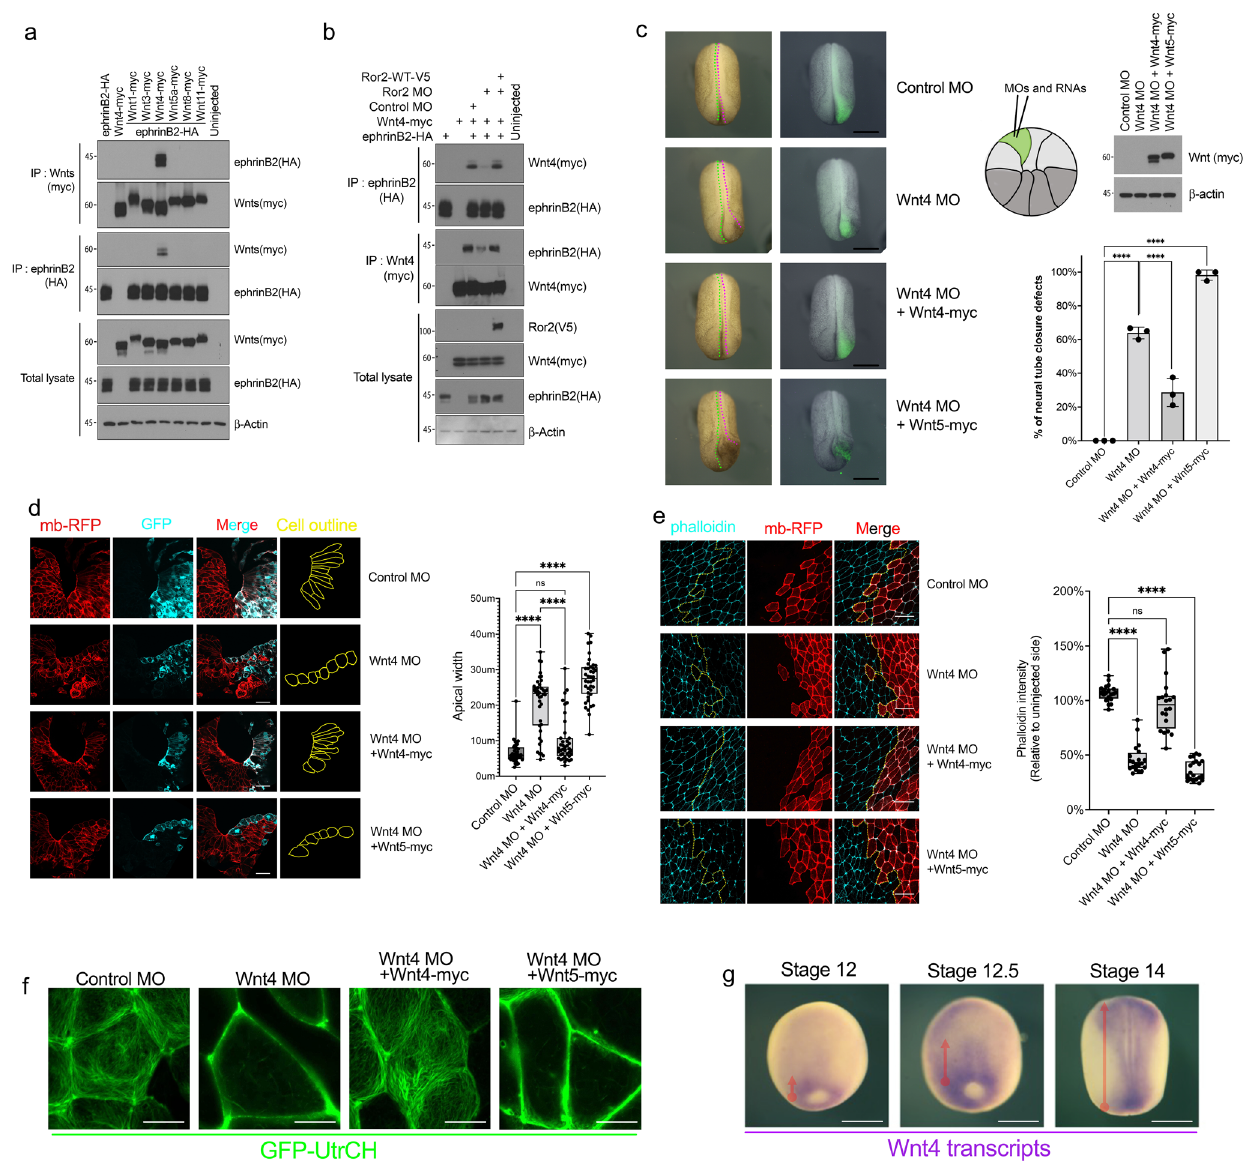
Fig. 3 | Wnt4 interacts with ephrinB2 via Ror2 to regulate apical constriction. a Co-IP assay with ephrinB2 (500pg) and Wnt ligands (100pg). b Co-IP assay with Wnt4(100pg)andephrinB2(100pg)inRor2morphants. c Representativeembryo morphology by Wnt4 knockdown (2ng). See also Supplementary Movie 1. Sche- matic of D1.1 microinjection in the 16-cell stage embryo. Membrane-GFP indicates injectedside.The lateralboundaries of the neural plate aremarked bydotted lines (green; uninjected side and magenta; injected side). Immunoblotting represents expression levels of Wnt4 and Wnt5a (50pg). Data means SEM. Numbers of embryos/experiments:55/3,64/3,57/3,and57/3fromlefttorightforeachcolumn. One-wayANOVAsfollowedbyDunnett ’ smultiplecomparisontestswereused.n.s., not signi fi cant, **** p <0.0001.Scale bar, 500 μ m. d Transverse section throughthe neural plate. Unilateral injection of MO and RNA as indicated. Membrane-RFP